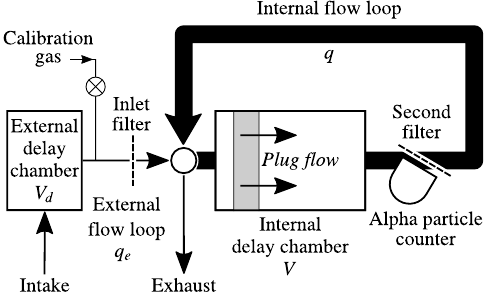
Figure 1. Process diagram of the dual-flow-loop two-filter radon de- tector. Wider arrows indicate higher flow rates. For the detector used in these tests, the inlet filter was a high efficiency particulate filter (Vokes Air Hepatex JK), and the second filter was a twill weave stainless steel mesh made from 20µ diameter wire with 20µ open- ings (635mesh, TWP Inc.). The alpha particle counter consisted of an assembly holding the filter, silver activated zinc sulfide scintilla- tion paper, and photomultiplier (9330B, ET